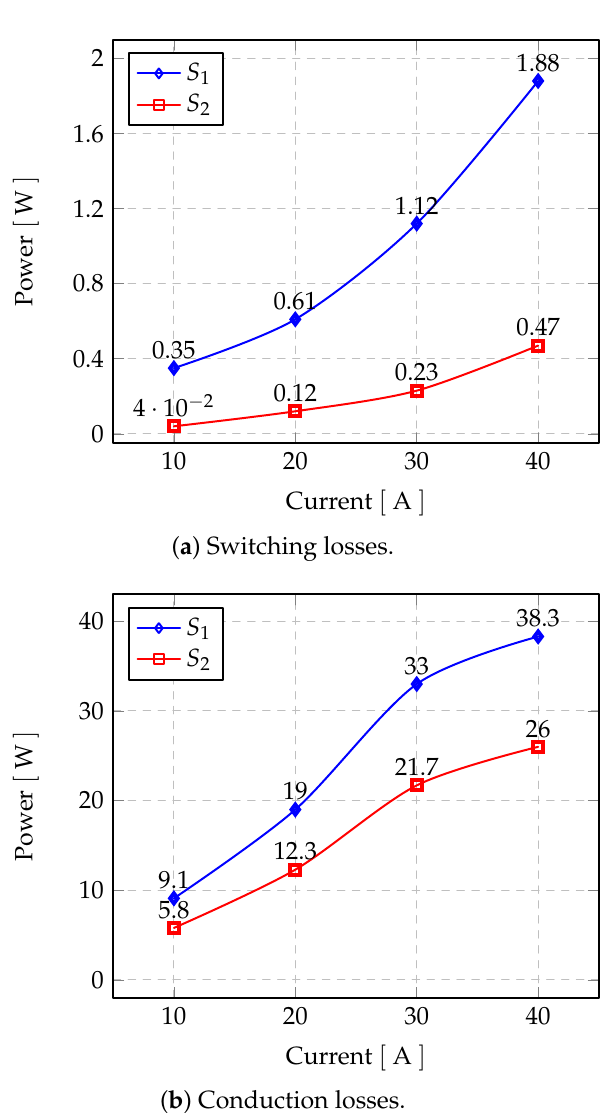
Figure 5. Switching and conduction losses of S 1 and S 2